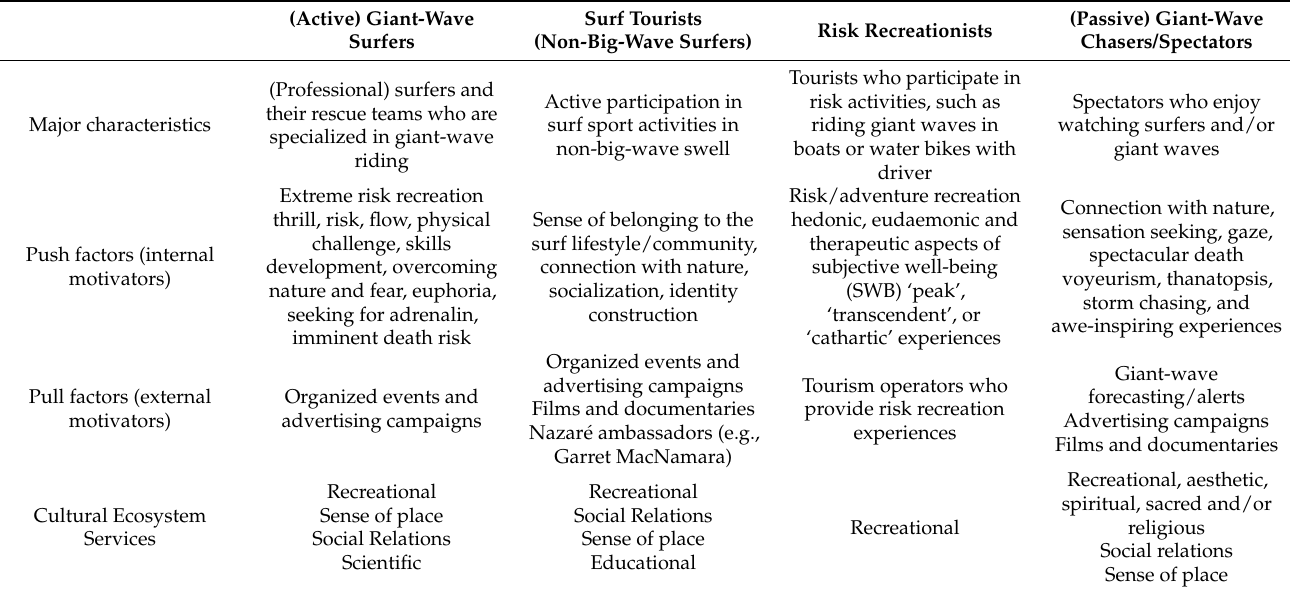
Table 2. Giant-wave surf tourism segments: characteristics, push and pull drivers, and cultural ecosystem